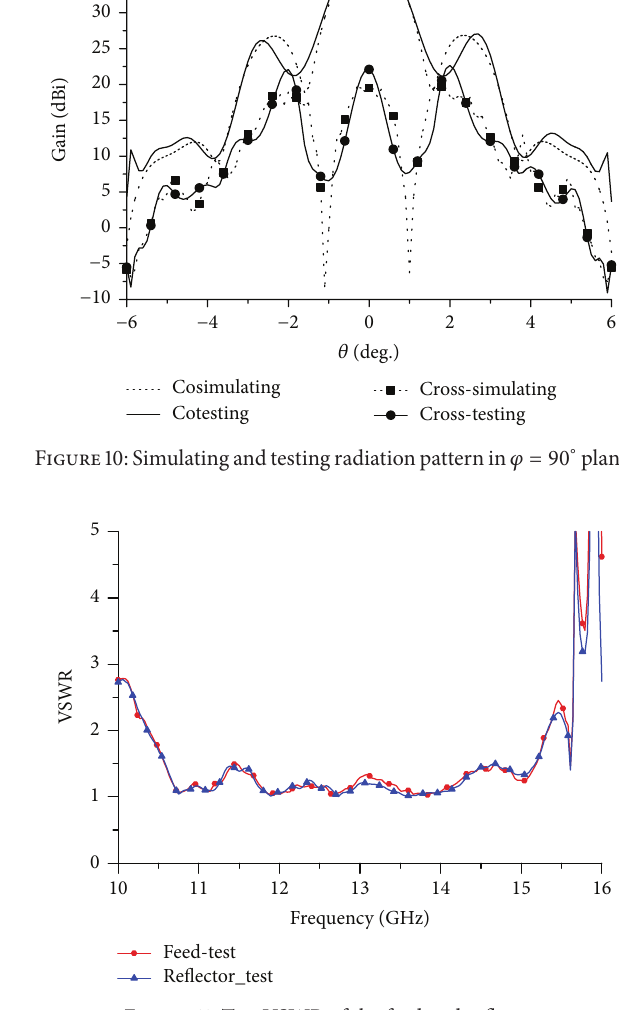
The 3 dB beam-width in 𝜑 = 0 ∘ , 𝜑 = 45 ∘ , and 𝜑 = 90 ∘